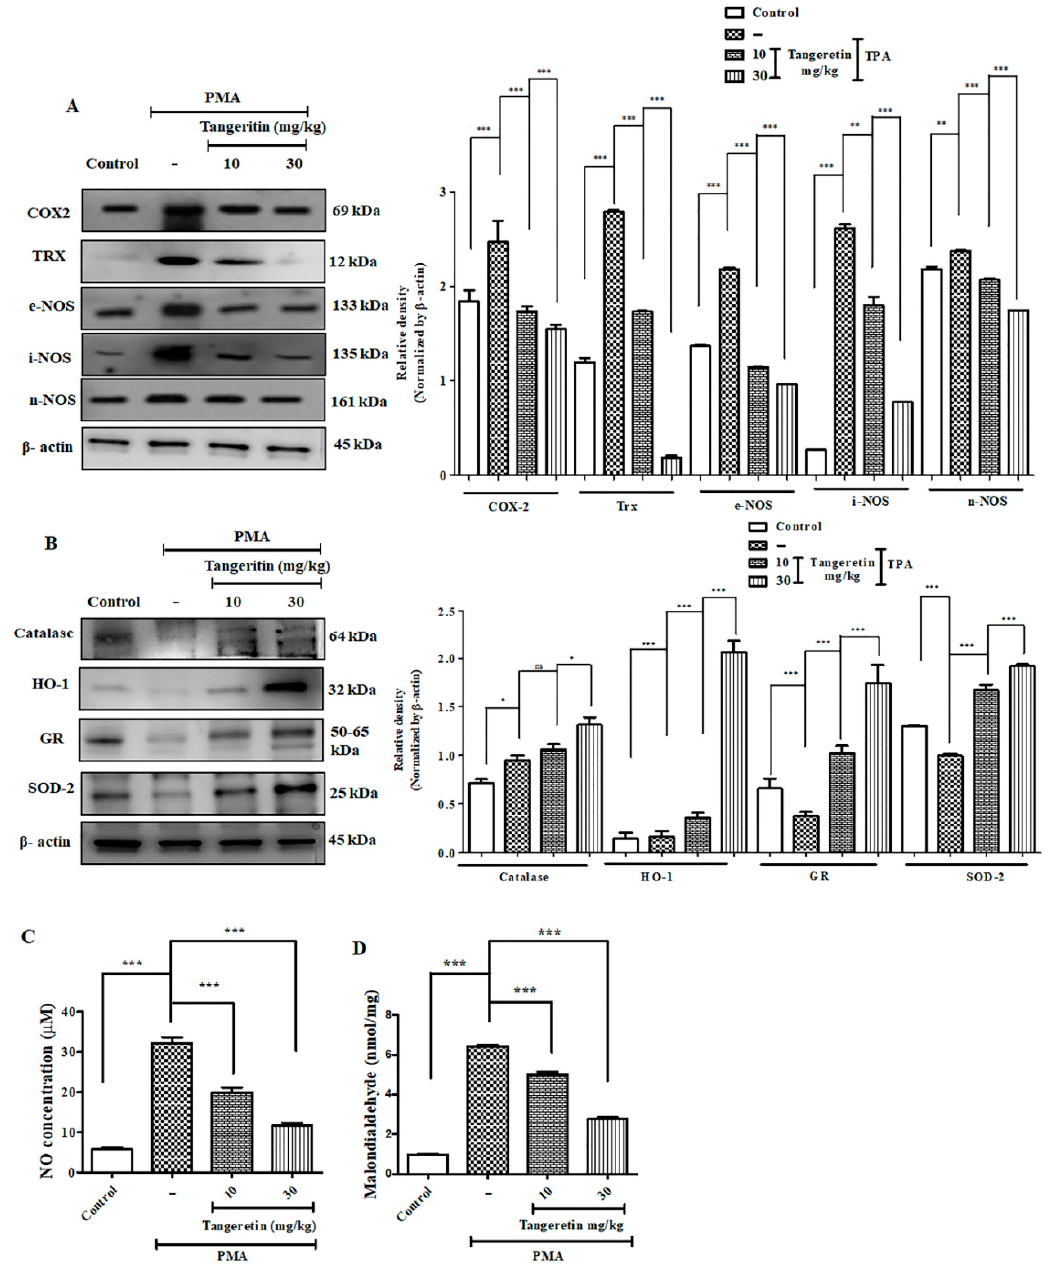
Figure 7. TAN neutralized PMA induced elevated ROS production by promoting antioxidant response. ( A ) Western blotting analysis of oxidative stress and inflammation markers evaluated from ear tissue homogenates, ( B ) Western blotting analysis of antioxidant activity markers evaluated from ear tissue homogenates, ( C ) Nitric oxide assay evaluated from mice ear tissue homogenates, ( D ) Malondialdehyde lipid peroxidation assay. Densitometry analysis of these respective proteins were normalized by β -actin and evaluated through Image J software. The data are represented as mean ± S.D. of three independent experiments * p < 0.05, ** p < 0.01, *** p < 0.001 and ns (non-significant). PMA vs. control, PMA vs. TAN 10 mg / kg and 30 mg / kg. Magnification = 200 × . Statistical significance analysis was carried out through a one-way analysis of variance (ANOVA) prism.